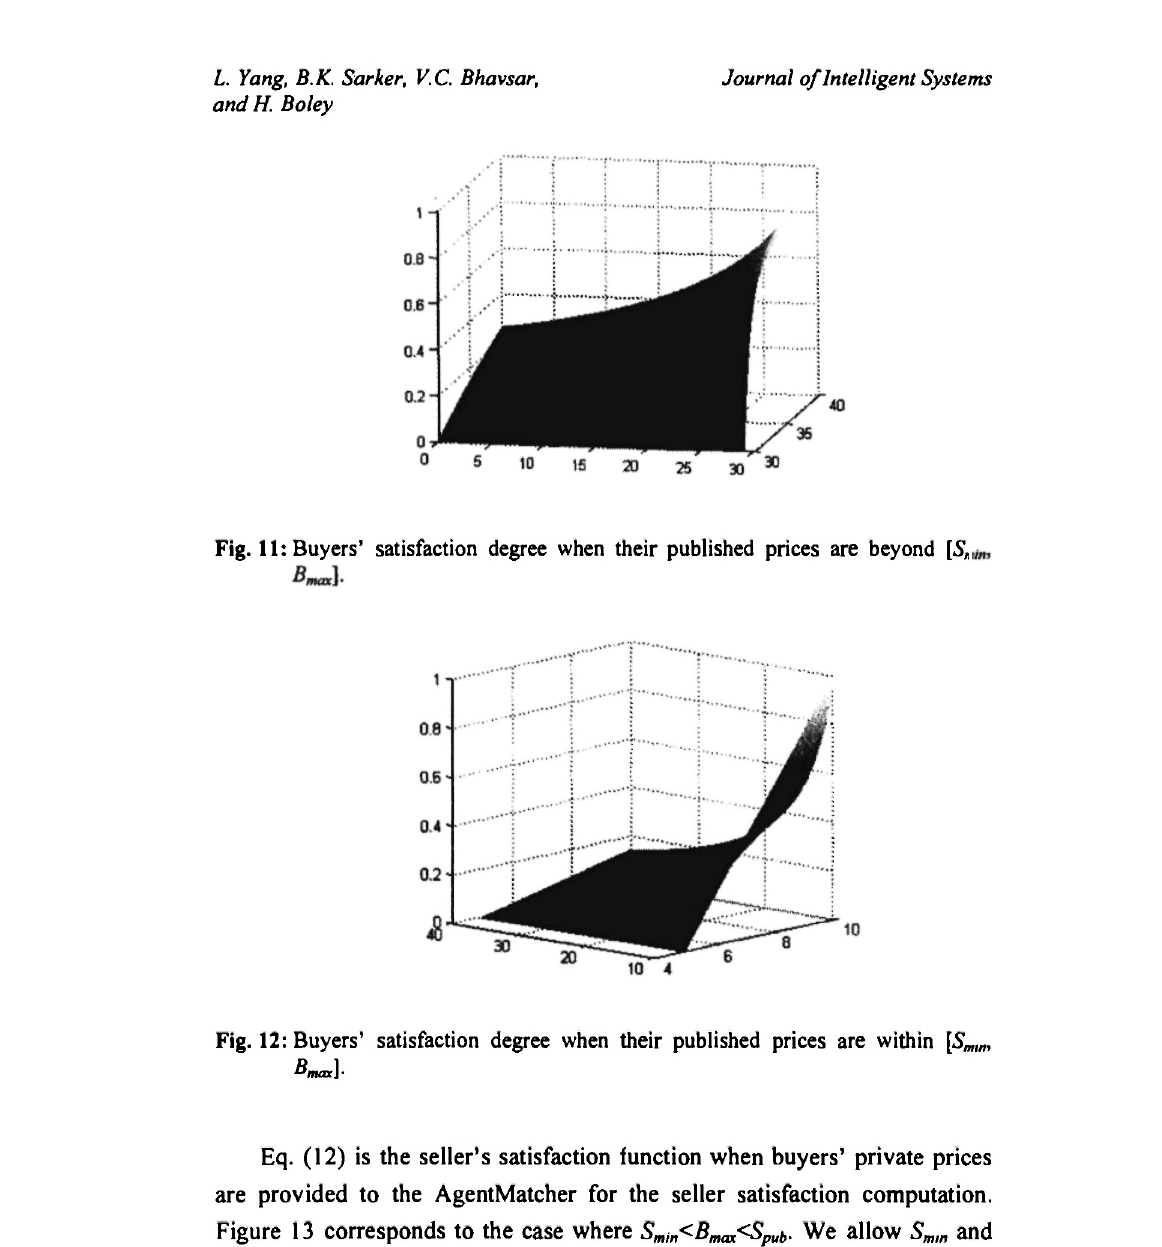
Fig. 12: Buyers' satisfaction degree when their published prices are within [5 m ,„, B m